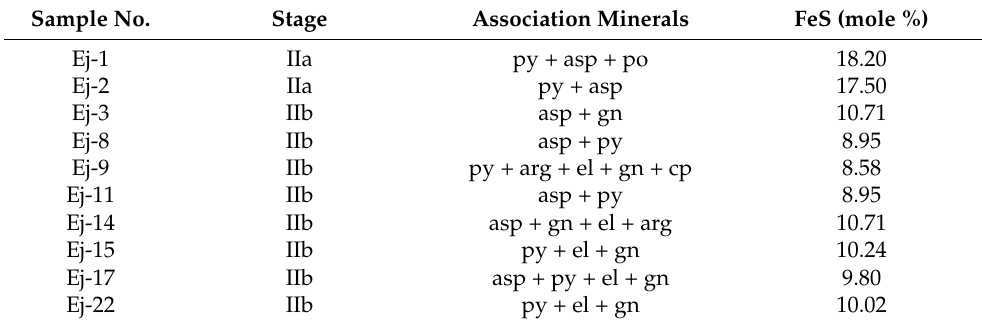
Table 4. FeS mole% of stage II sphalerites by EPMA analyses from the Eunjeok Au–Ag deposit. Sample No.